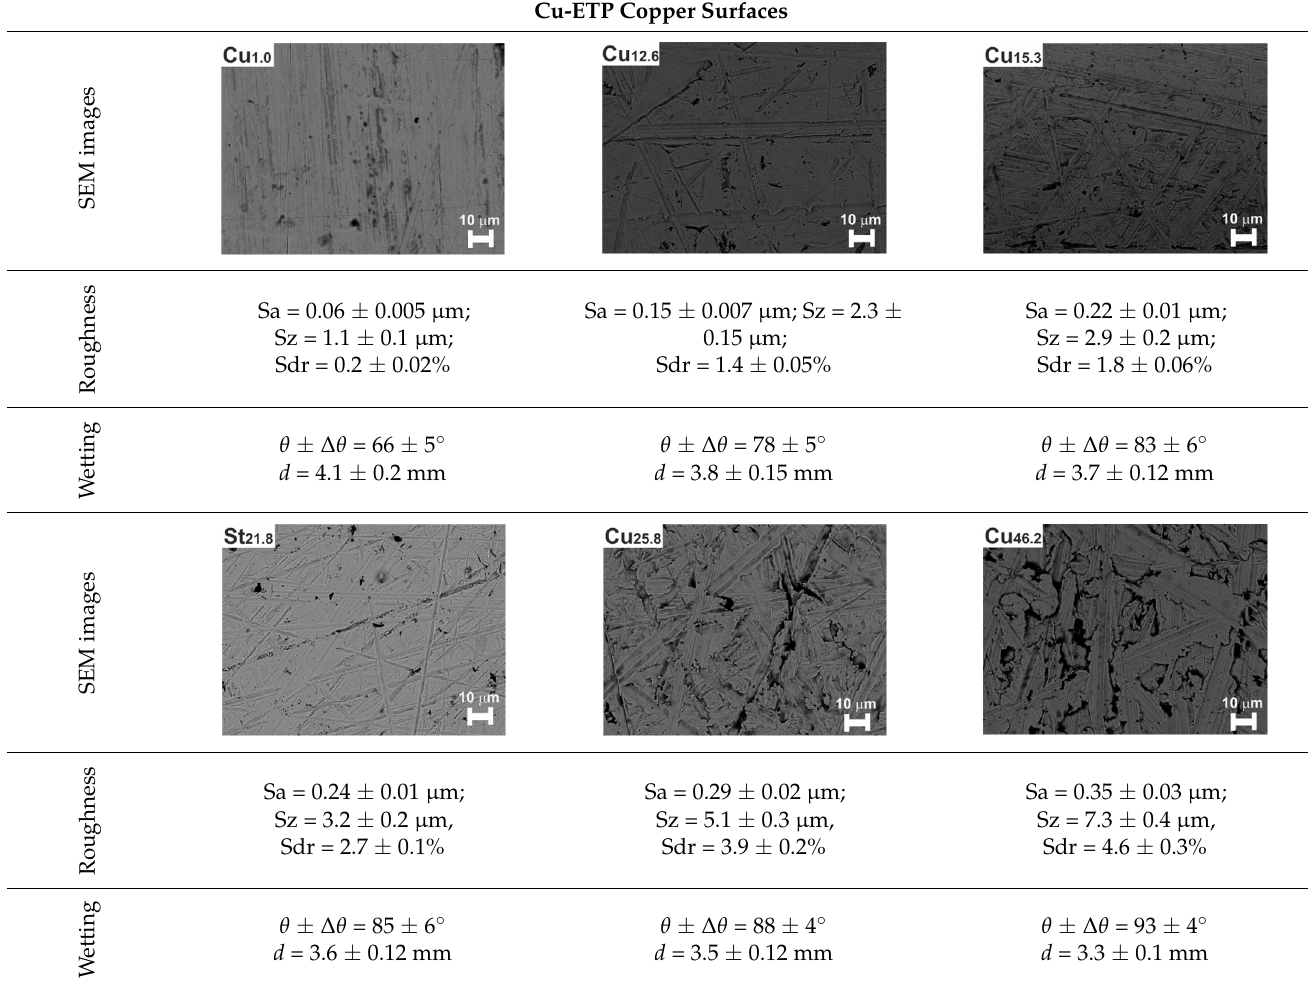
Table 1. SEM images and parameters characterizing roughness and wetting of copper surfaces.